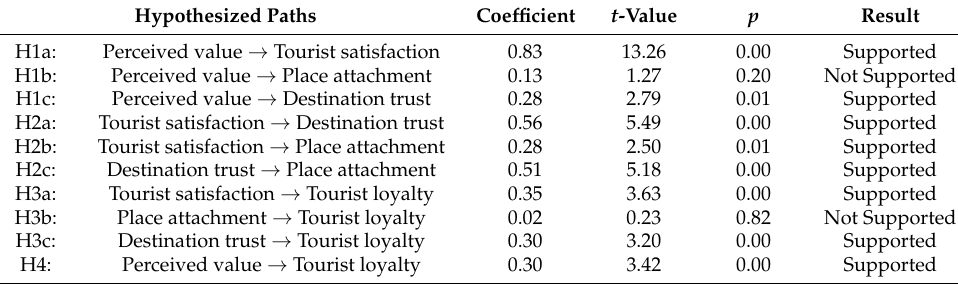
Figure 2. Results of the hypotheses test. Note. *** p < 0.001. Table 4. Hypothesis testing results. Table 4. Hypothesis testing